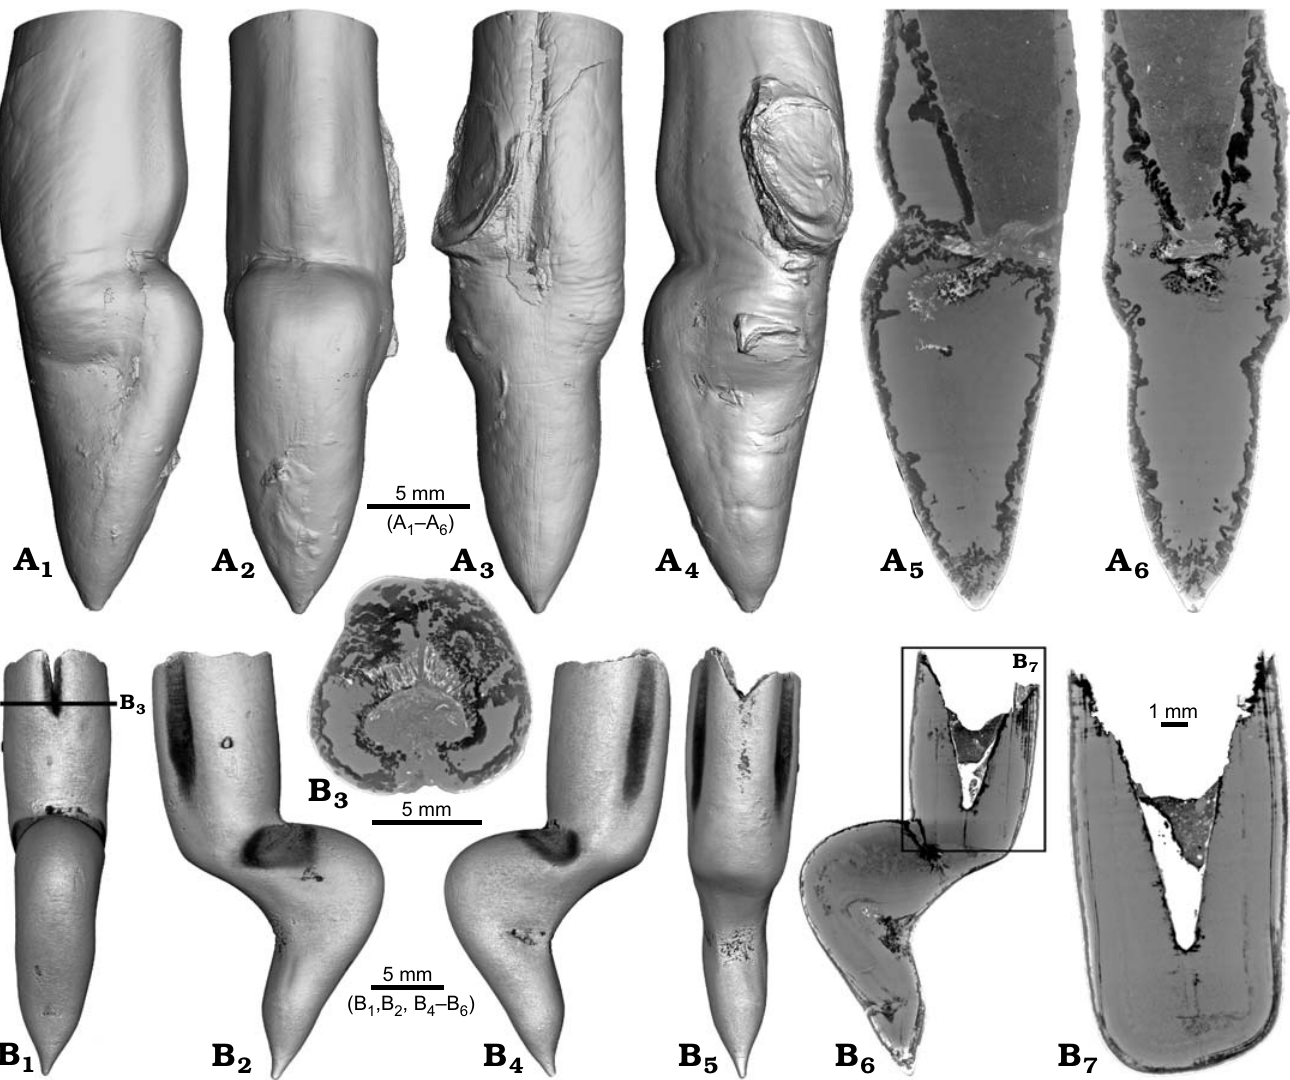
Fig. 6. Rostra of belemnite Gonioteuthis spp. A . RUB-Pal 11302, Campanian, Höver (NW-Germany) with forma aegra angulata (coll. U Frerichs). Surface images showing the knee-like morphology of the rostrum, and the attachment-base of an oyster, in lateral (A 1 , A 4 ), dorsal (A 2 ), and ventral (A 4 ) views; note the weak furrows in A 3 . Median sections perpendicular to each other showing silicified areas (darker) and the broken phragmocone now filled with sediment, no additional internal feature visible (A 5 , A 6 ). B . SNSB-BSPG-83246, Campanian, Höver (NW-Germany) with forma aegra angulata (coll. H. Keupp, leg. C. Spaeth). Surface images showing the knee-like morphology of the rostrum, in ventral (B 1 ), lateral (B 2 , B 4 ), and dorsal (B 5 ) views. Cross section (B 3 ). Median sections showing silicified areas specifically at places heavily bent (darker) (B 6 , B 7 ); see also A 5 , A 6 for the same phenomenon. Black box indicates close up in B 7 , showing the broken juvenile rostrum with growth increment (forma aegra clavata), and the phragmocone partially filled with pyrite